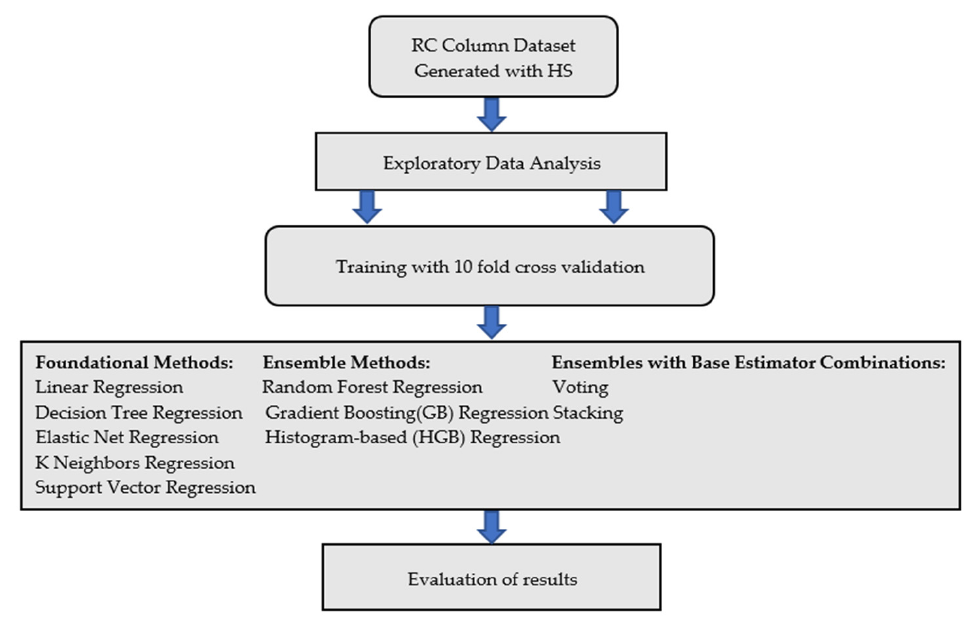
Figure 8. Flowchart for the creation and evaluation of machine learning models.